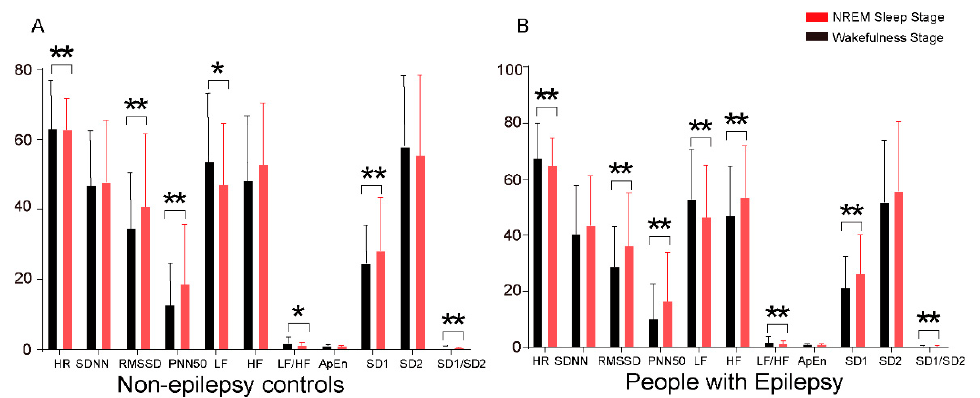
Figure A1. Parasympathetic nerves predominate in non-rapid eye movement (NREM) sleep stage compared with wakefulness stage. ( A ) Compared with wakefulness stage, decreased HR, LF and LF/HF, increased RMSSD, PNN50, SD1 and SD1/SD2 have been observed in NREM sleep stage in non-epilepsy controls (Wilcoxon matched-pairs signed rank test, HR p = 0.0041, RMSSD p = 0.0003, PNN50 p = 0.0008, LF p = 0.0379, LF/HF p = 0.0164, SD1 p = 0.0048, SD1/SD2 p = 0.019). ( B ) Compared with wakefulness stage, decreased heart rate (HR), LF and LF/HF, increased RMSSD, PNN50, HF, SD1 and SD1/SD2 have been observed in NREM sleep stage in people with epilepsy (Wilcoxon matched- pairs signed rank test, HR p < 0.0001, RMSSD p < 0.0001, PNN50 p < 0.0001, LF p < 0.0001, HF p < 0.0001, LF/HF p < 0.0001, SD1 p < 0.0001, SD1/SD2 p = 0.0003). * HR—heart rate; SDNN—standard deviation of all RR intervals; RMSSD—root mean square of the difference of adjacent RR intervals; PNN50—probability of RR intervals greater than 50 ms or smaller than − 50 ms; LF—low frequency power (0.04–0.15 Hz); HF—high frequency power (0.15–0.4 Hz); * p < 0.05, ** p <